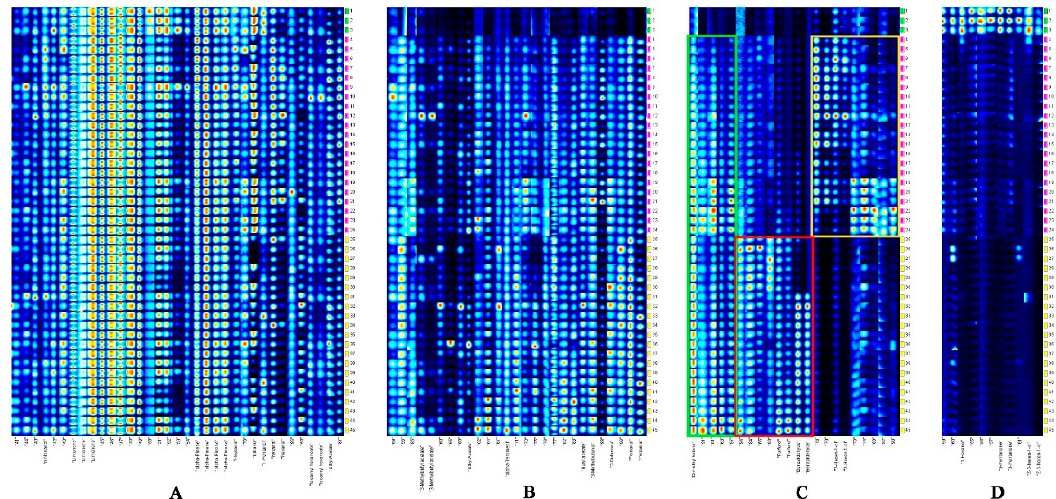
Figure 4. Four parts of the screenshots from the fingerprints. Nine kinds of identified peaks ( A ); Seven kinds of identified peaks ( B ); Four kinds of identified peaks ( C ); Three kinds of identified peaks ( D ).